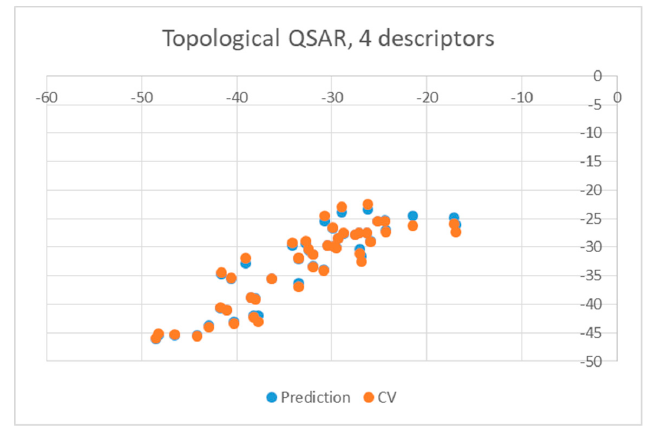
Figure 3. Obtained topological quantitative structure-activity relationship (QSAR) results obtained with four descriptors for wild type. Pharmaceuticals 2019 , 12 , 64